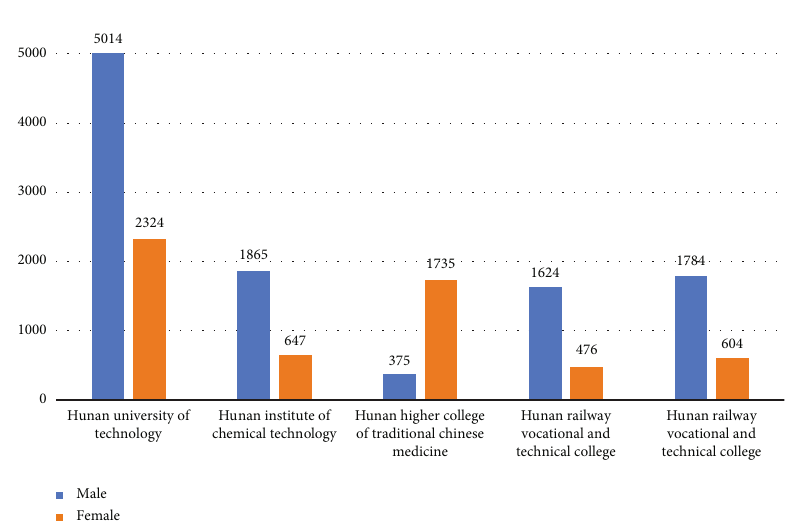
Figure 2: Number of Hunan colleges and universities in class 15.